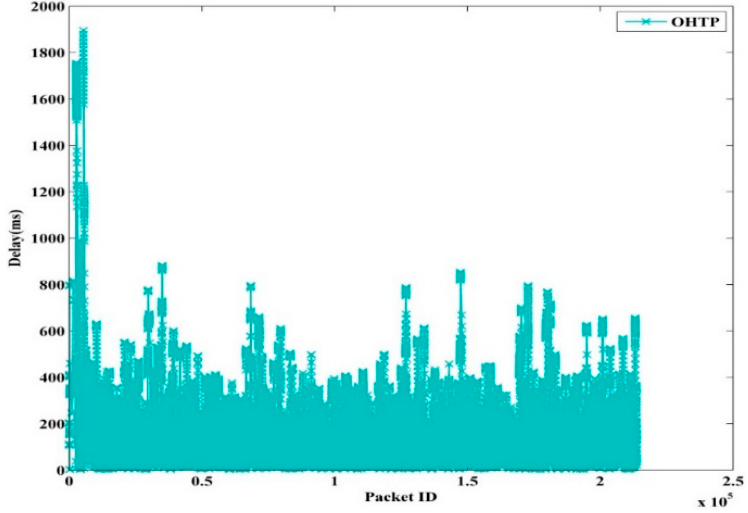
Figure 12. OHTP Packet Delay.